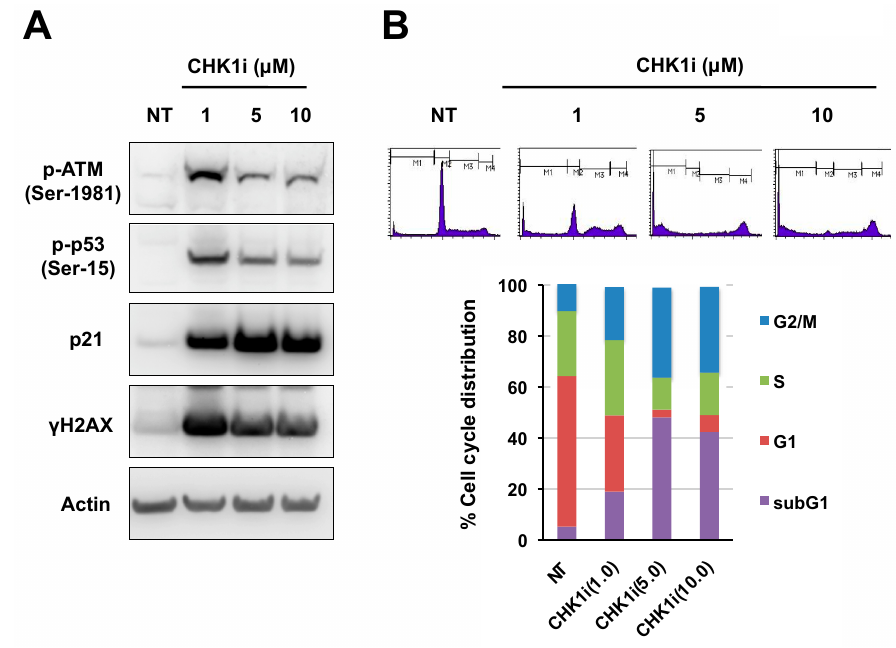
Figure 3. CHK1 inhibition induces double-strand break (DSB)-mediated DDR signaling. ( A ) Immunoblot analysis of the indicated proteins in NB-39-nu cells after treatment with DMSO (0, NT), 1, 5, or 10 µM CHK1i (PF-477736) for 24 h. ( B ) Flow cytometric cell cycle analysis of cells treated as for ( A ) and then stained with propidium iodide (PI) to assess the cell cycle distribution. Upper panels show the PI histograms; lower panels show the proportion of cells in each phase of the cell cycle after the indicated treatments.